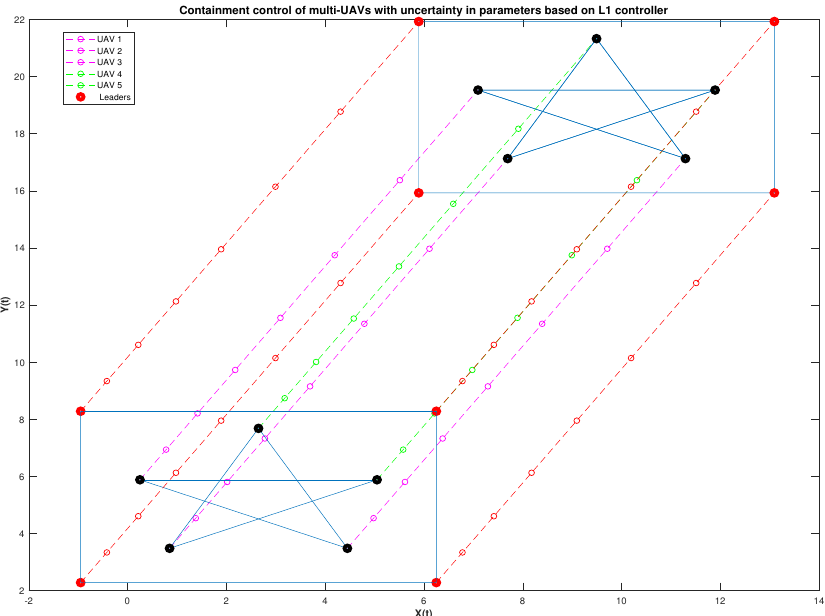
Figure 10. Full map of UAVs containment based on L 1 adaptive control with parameters